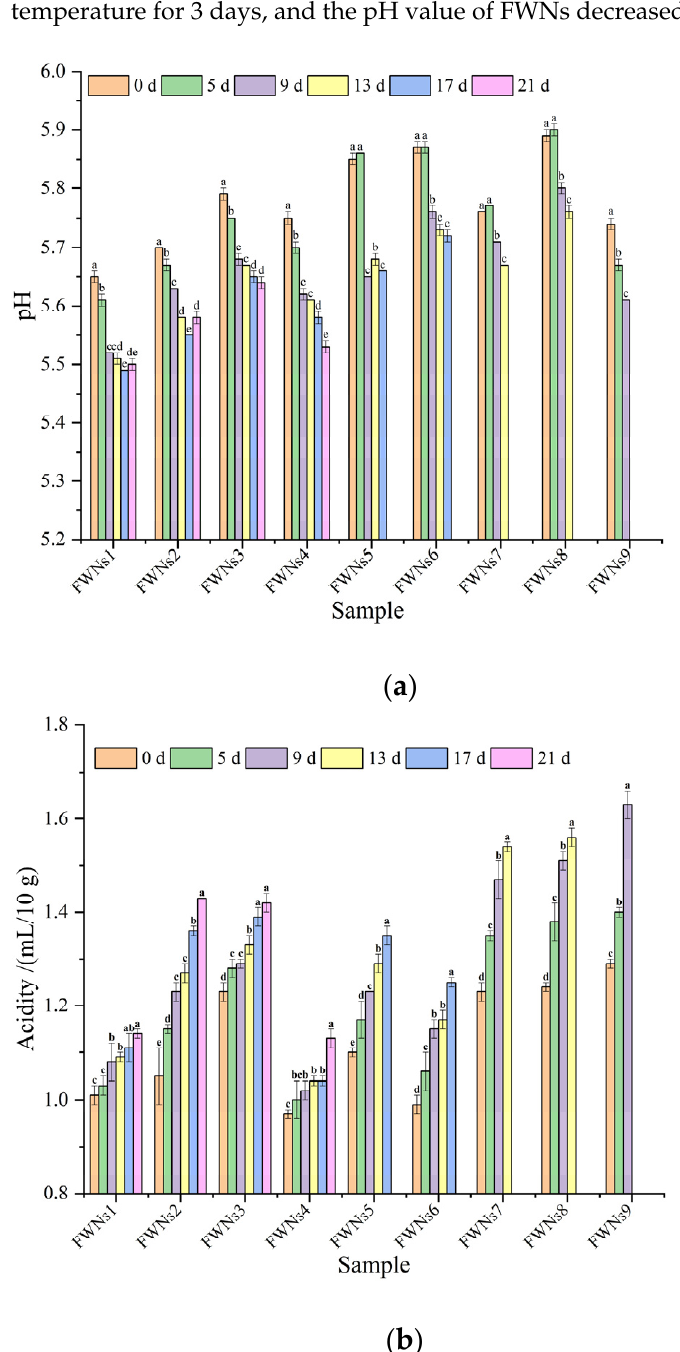
Figure 2. Changes of pH value ( a ) and acidity ( b ) in FWNs1 − FWNs9 samples during storage at 4 °C. Different letters in the same group represent significant differences ( p < 0.05).